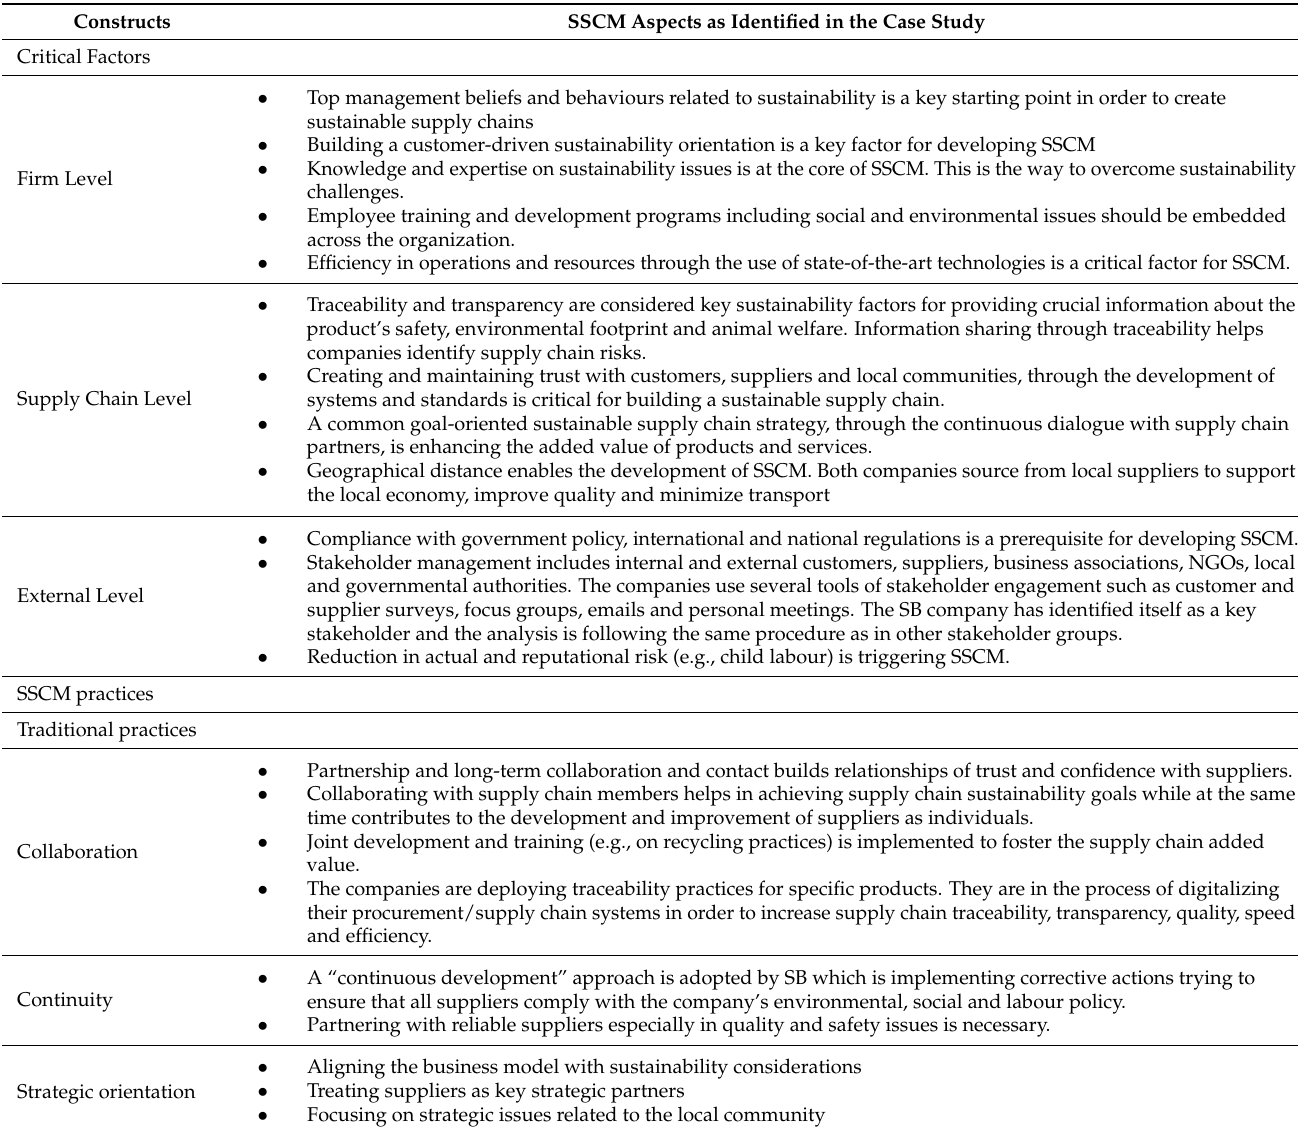
Table 3. Aspects of SSCM as identified in the case